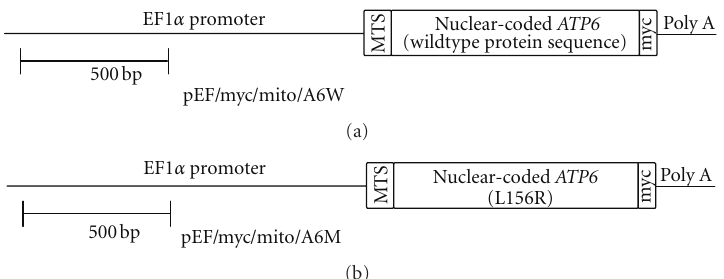
Figure 1: Schematic representation of AE DNA constructs. High-level transcription is driven by the human EF1 α promoter. Protein-coding elements include the N-terminal mitochondrial transport signal of human cytochrome oxidase VIII, nuclear-coded wild-type (a) or mutant (b) mouse Atp6 gene sequence and a C-terminal myc epitope